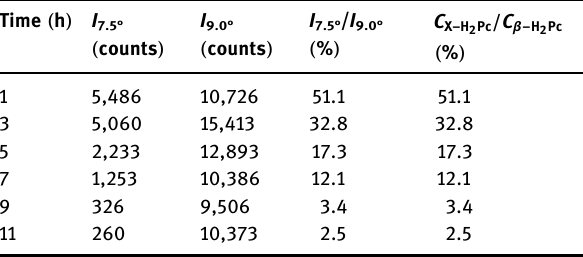
Table 1: Relationship between